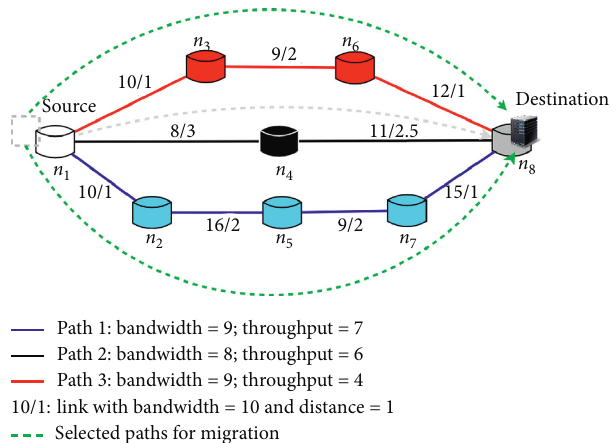
Figure 9: Best replacement path selection with throughput as one of selection criteria instead of bandwidth.